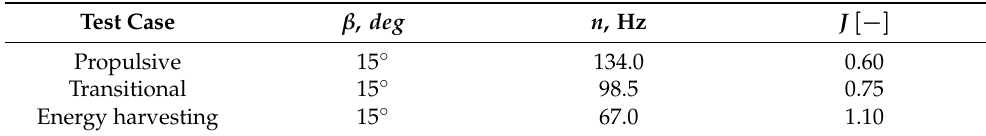
Table 1. Pitch angle β , rotational speed n and advance ratio J values for each operational condition